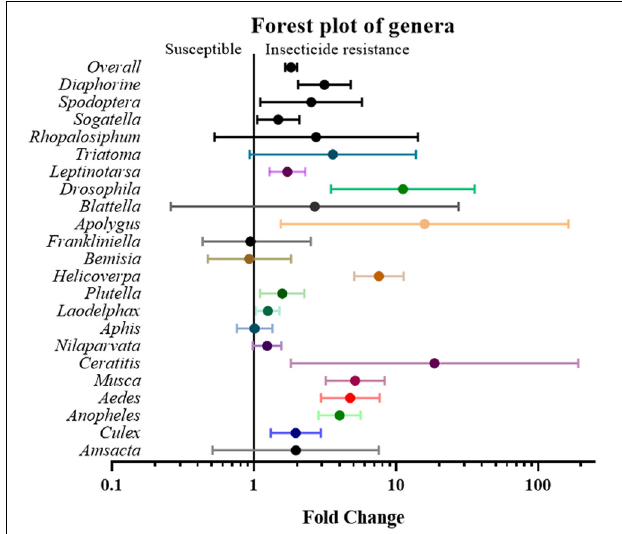
FIGURE 5 | Meta-analytical, sub-group estimate of the gene expression related to insecticide resistance, with 95% CI in different insect genus and vector types. The overall effect represents the collective effect of all the relevant studies.